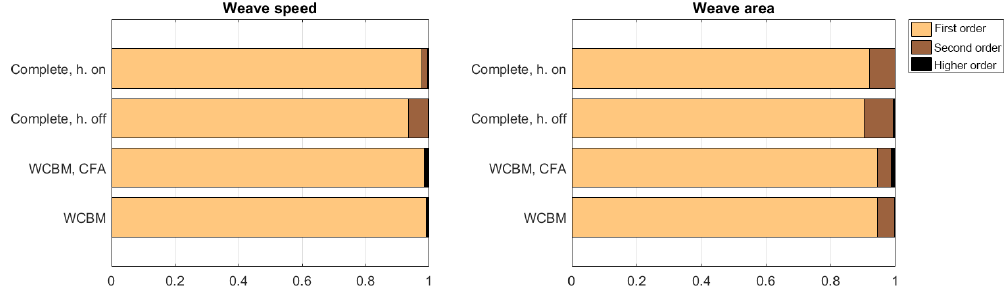
Figure 6. Sensitivity of the weave mode to first, second, and higher orders of interaction. Models of increasing complexity from bottom to top.